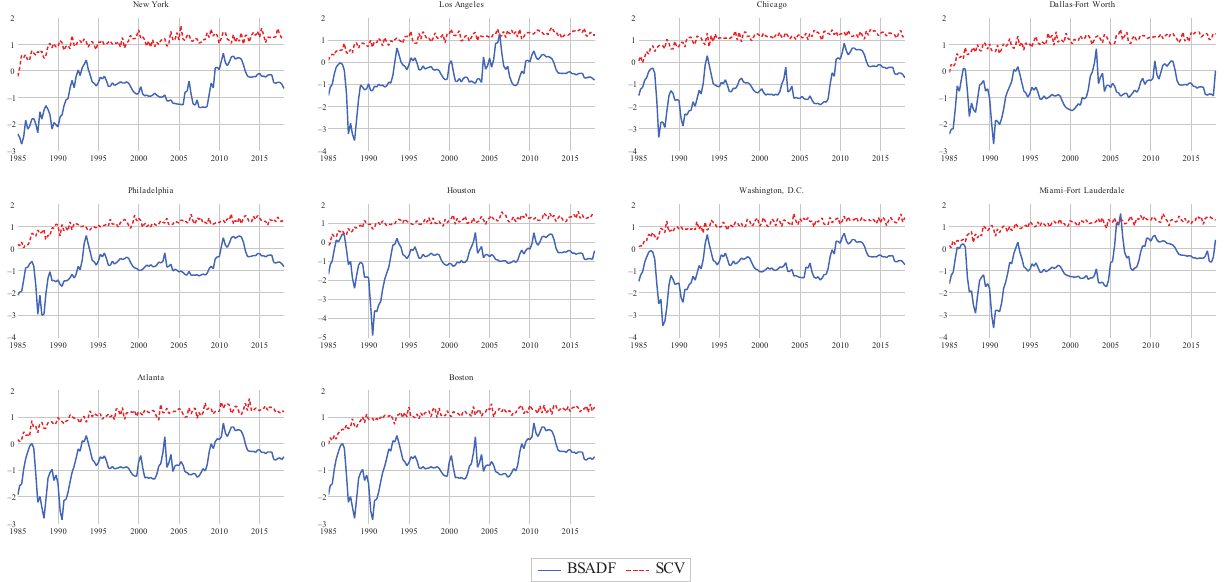
Figure 7. BSADF test using user costs and rental costs